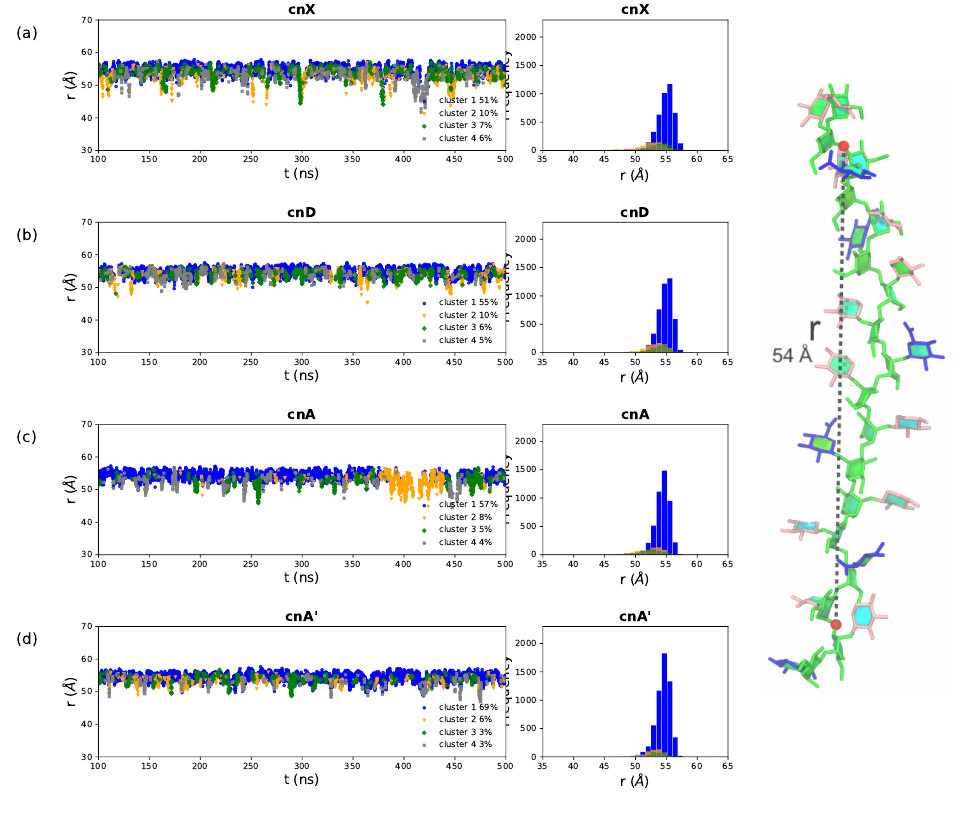
Figure A3. The end-to-end distance, r , time series and corresponding histograms of the dominant conformational clusters for the ( a ) cnX, ( b ) cnD, ( c ) cnA and ( d ) cnA’ GXM chains. For each molecule, the end-to-end distance of the dominant conformational cluster is plotted in blue, the secondary conformational cluster in orange, tertiary in green and quaternary in grey. Lesser clusters are not shown. Percentages for each cluster relative to the total simulation are listed in the legends. The first 100 ns of simulation are considered equilibration and are not shown. Here r is defined to exclude the two terminal residues on either end of the chain, as the distance from O3 in the second linkage to O3 in the 16th linkage in the 18-mannose backbone—labeled for cnA in the image on the right. The residues and substitutions are coloured as follows: α DMan—green; β DGlcA—blue; β DXyl—pink and